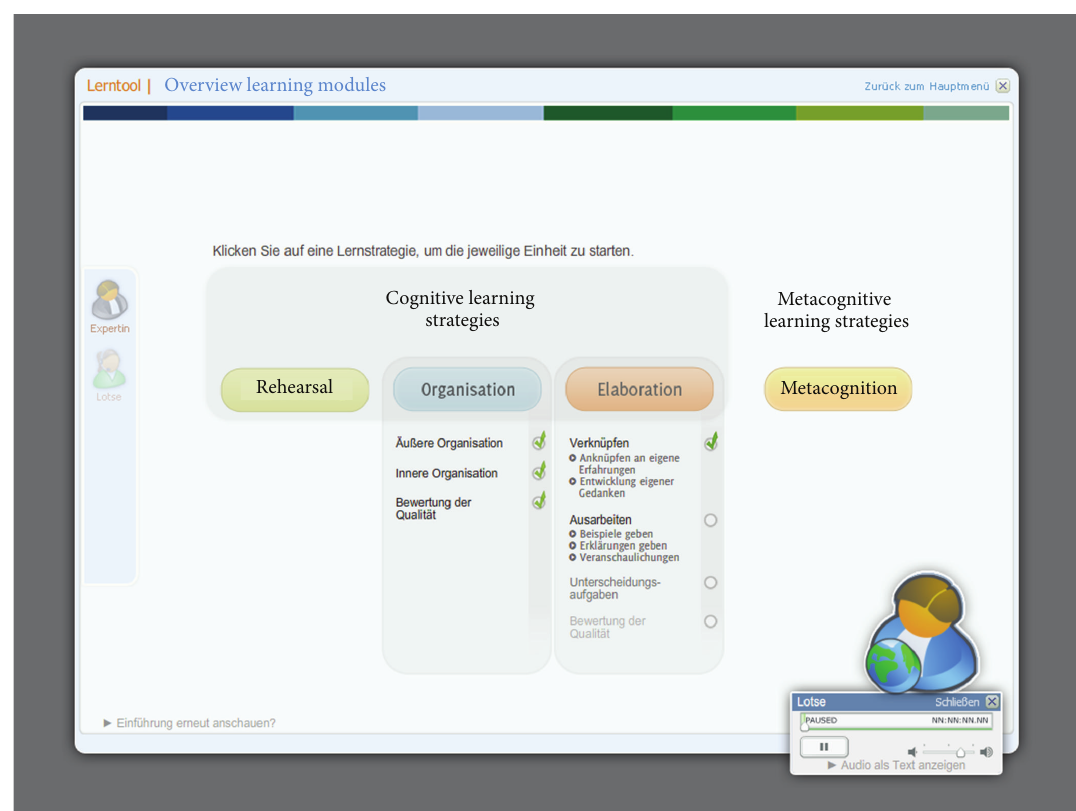
Figure3:Overviewsiteoftheinteractivelearningenvironment(Section3oftheCBLE)withthreemodulesaboutcognitivelearningstrategies (rehearsal, organization, and elaboration) and one module on metacognitive strategies. Here, the organization module was finished (green check marks), and the elaboration module was